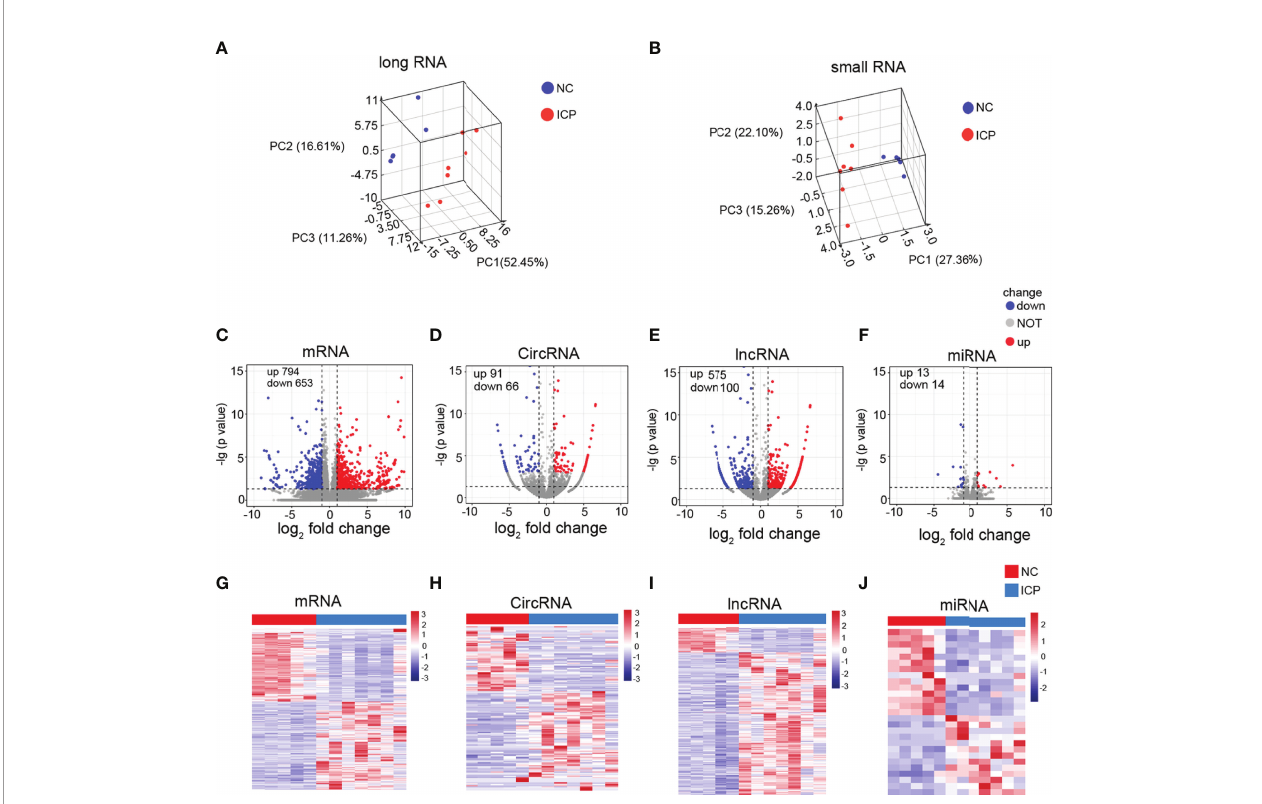
FIGURE 2 | Identi fi cation of the DERNAs in placenta tissue of ICP. (A, B) Box plots: the distributions of the datasets for long RNAs (A) and small RNAs (B) of twelve samples. (C-F) Volcano plots of the DEmRNAs (C) , DEcricRNAs (D) , DElncRNAs (E) , and DEmiRNAs (F) (red, up-regulated; blue, down-regulated). (G-J) Heatmaps for DEmRNAs (G) , DEcricRNAs (H) , DElncRNAs (I) , and DEmiRNAs (J) (red, up-regulated; green,